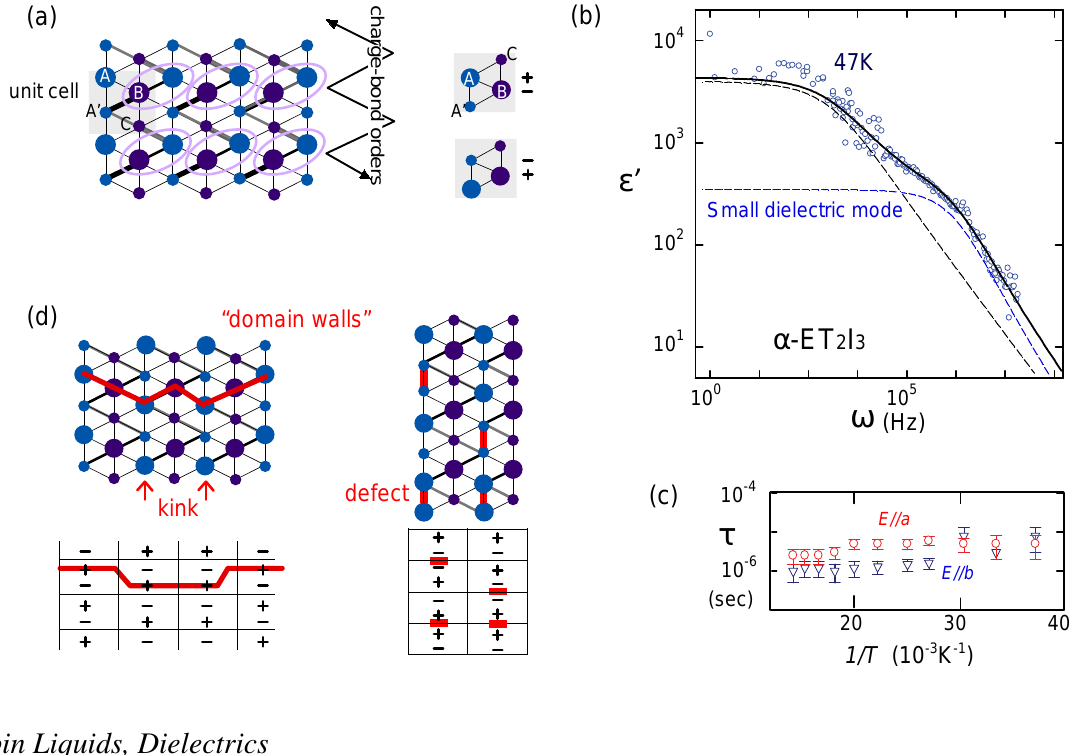
Figure 21. ( a ) Charge and bond orders of α -ET unit cell includes four independent sites, A, A (cid:48) , B, C, where A and A (cid:48) have inversion crystallographically; ( b ) Dielectric constant of α -ET time of the small dielectric mode (fitted in broken lines), adapted with permission from [90], copyrighted by the American Physical Society; ( d ) Sketch of the configuration of charges related to the small dielectric mode. The large/small circle indicate the charge rich/poor site, and “+-” and “-+” are the polarization of A and A (cid:48) molecules in a unit cell (see ( a )).